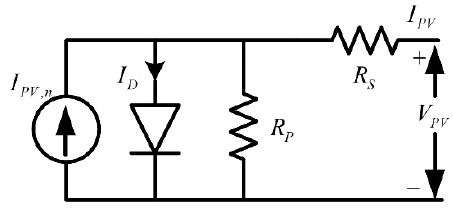
Figure 3. Ideal single-diode PV Model.